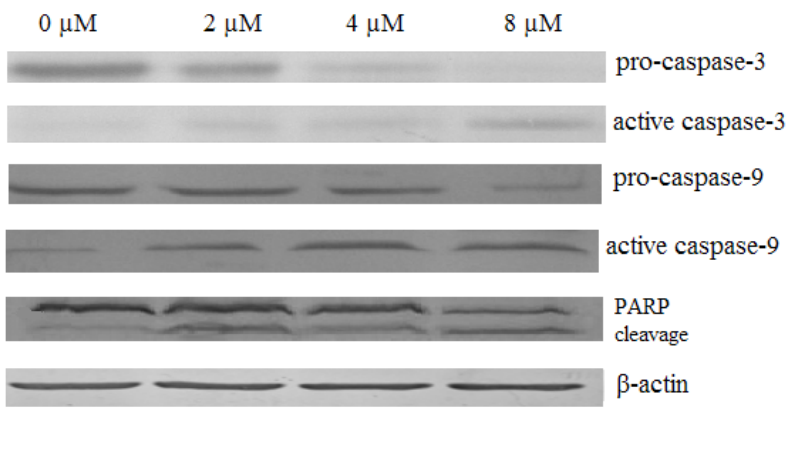
Figure 9. Effects of chamaejasmine on expression of caspases and PARP. A549 cells were treated with different concentrations of chamaejasmine for 48 h. The full length and cleaved protein fragments of caspase-3, caspase-9, and PARP were detected by Western blot. The results demonstrated dose-dependent chamaejasmine induced cleavage of caspase-3, caspase-9 and PARP. These figures are one representative experiment of three with similar results. β -actin served as a loading